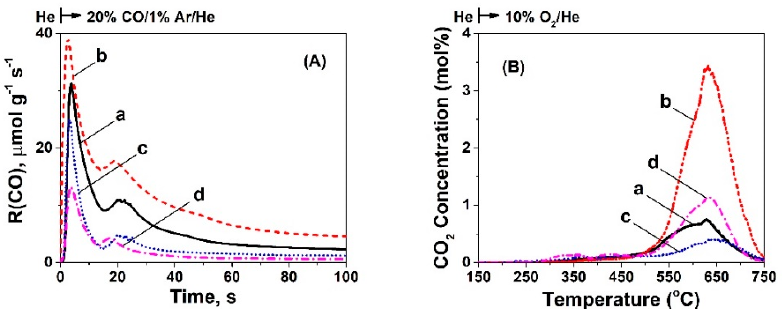
Figure 6. Transient rates ( µ mol g − 1 s − 1 ) of ( A ) CO consumption as a function of time after the gas switch He → 20 vol% CO / 1 vol% Ar / He (50 NmL min − 1 ; GHSV ~30,000 h − 1 ) at 750 ◦ C. ( B ) Transient response curves of CO 2 concentration obtained during TPO of carbon formed after 30 min of CO dissociation at 750 ◦ C over 5 wt% Ni / CeO 2 prepared by (a) Thermal decomposition (TD), (b) Precipitation (PT), (c) Hydrothermal (HT), and (d) Sol-Gel (SG) method.